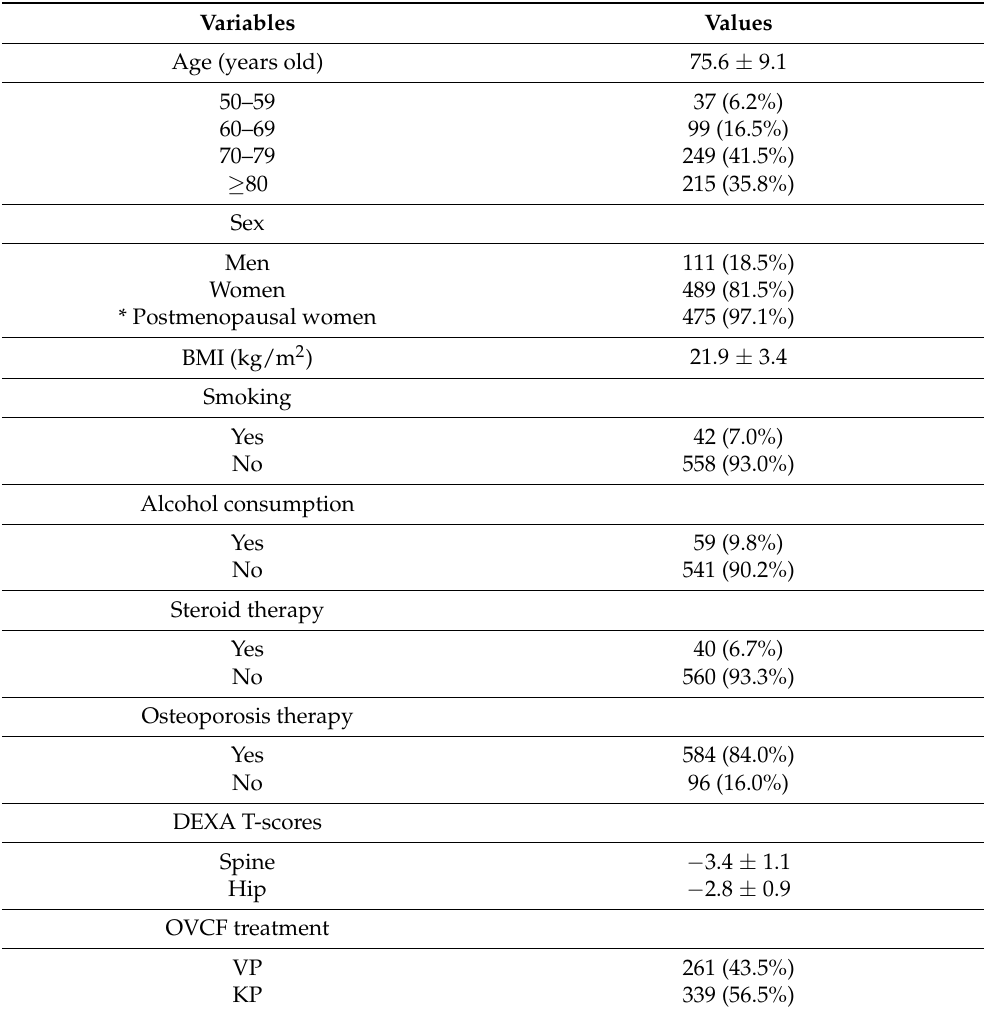
Figure 2. Distribution of the patients’ age. Table 1. Baseline characteristics of the patients ( n =